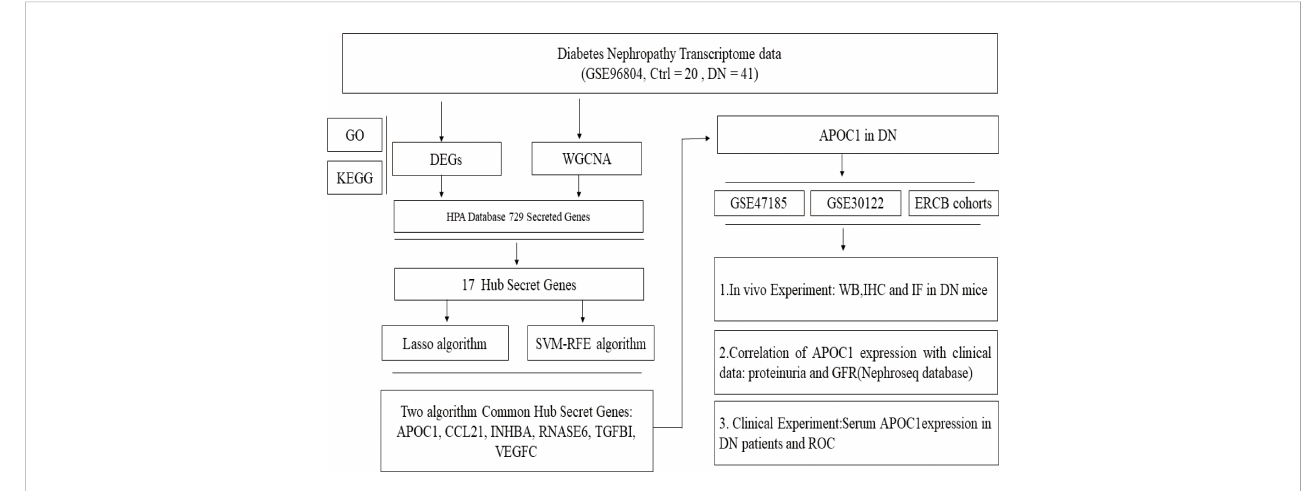
FIGURE 1 Research fl ow